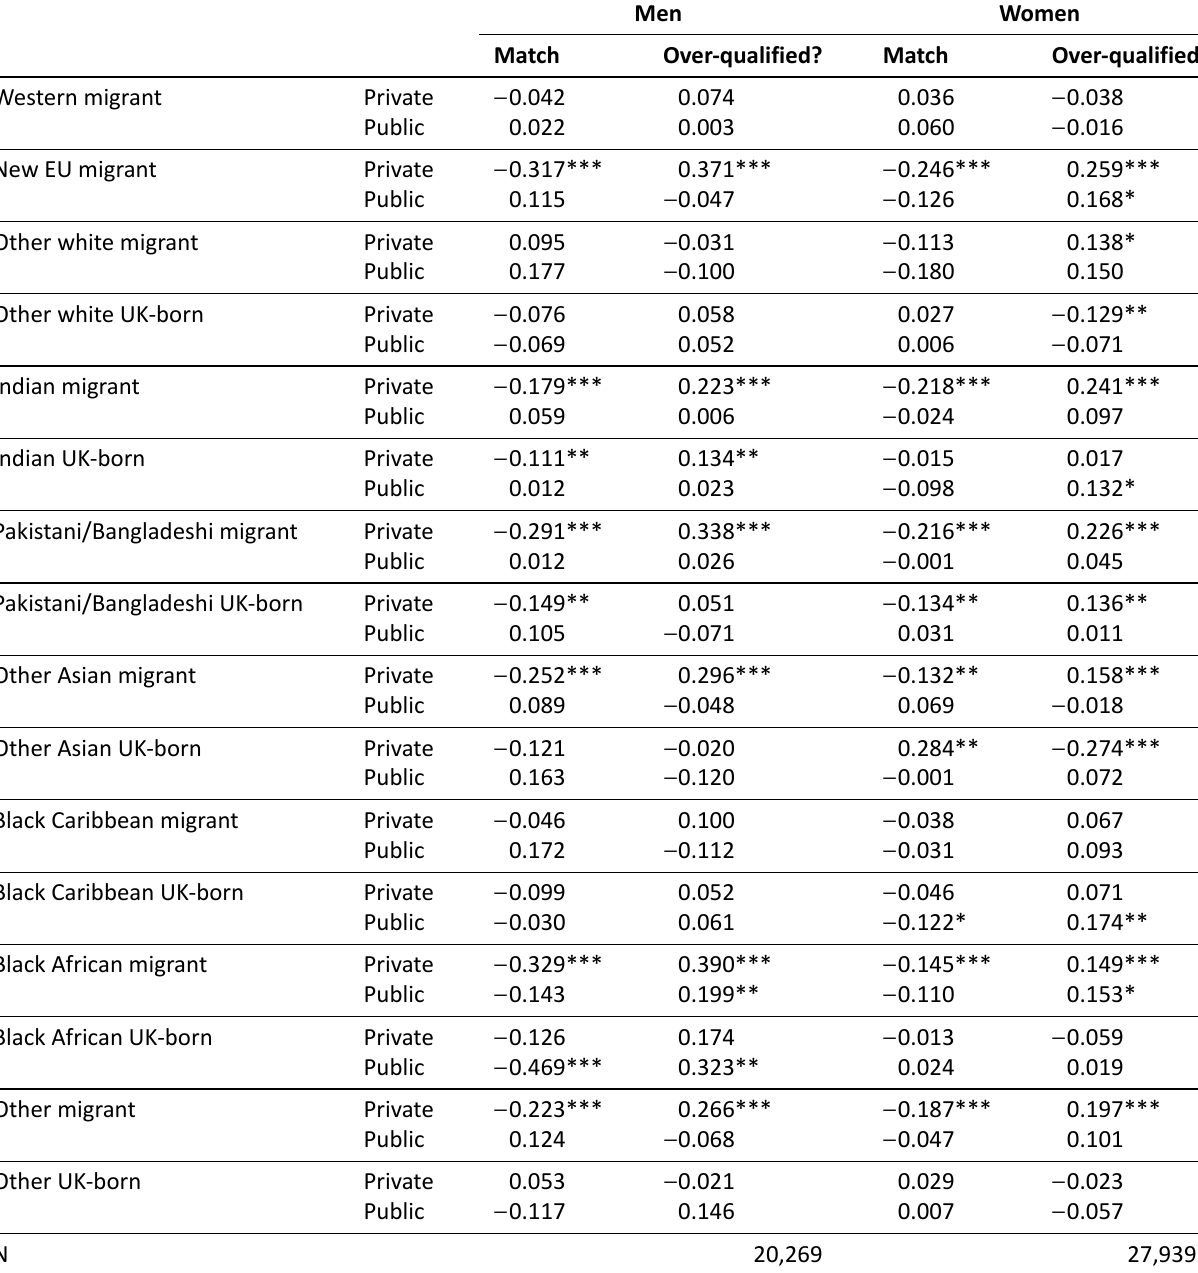
Table 1. Estimated difference in predicted probability of being matched or over-qualified for job compared to white British majority, for those with post-secondary qualifications by gender and